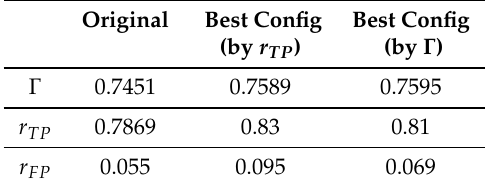
Table 3. TP rate, FP rate and compromise values for original catalog, best configuration by TP rate and best configuration by compromise